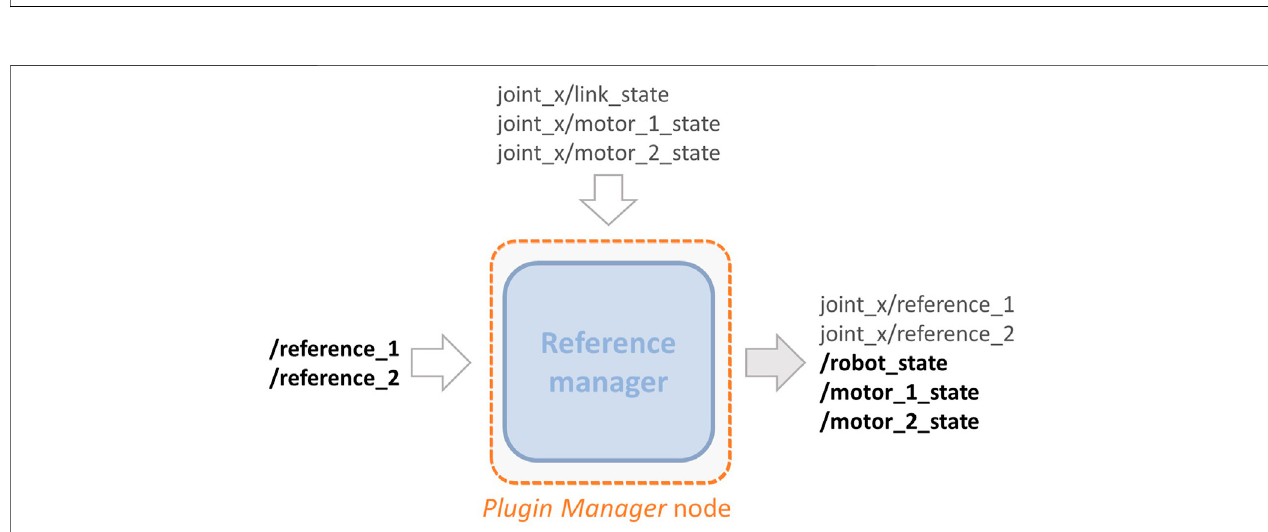
FIGURE 8 | Detailed representation of the topics that the Plugin Manager node publishes and subscribes to.